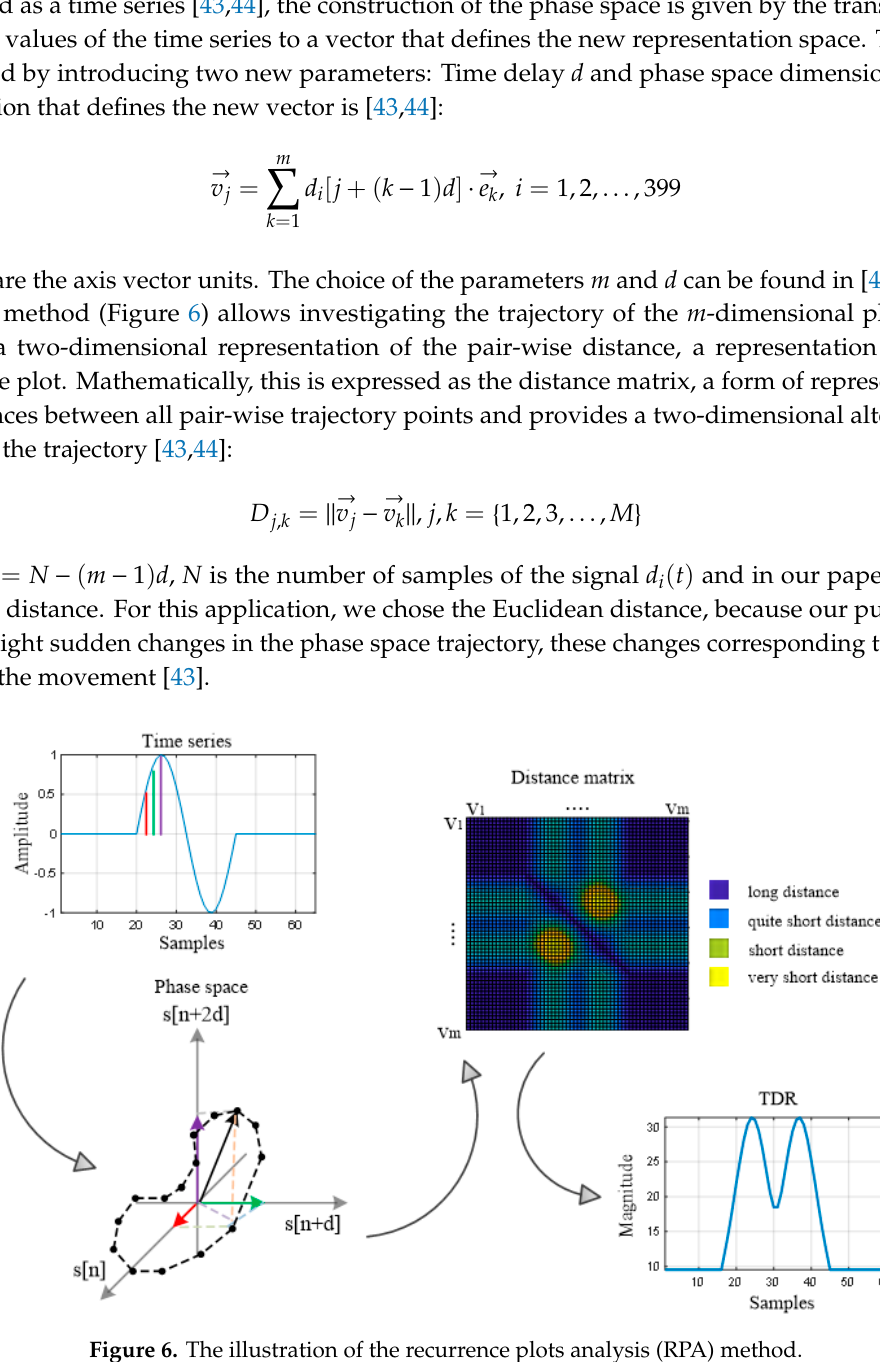
Figure 6. The illustration of the recurrence plots analysis (RPA) method.